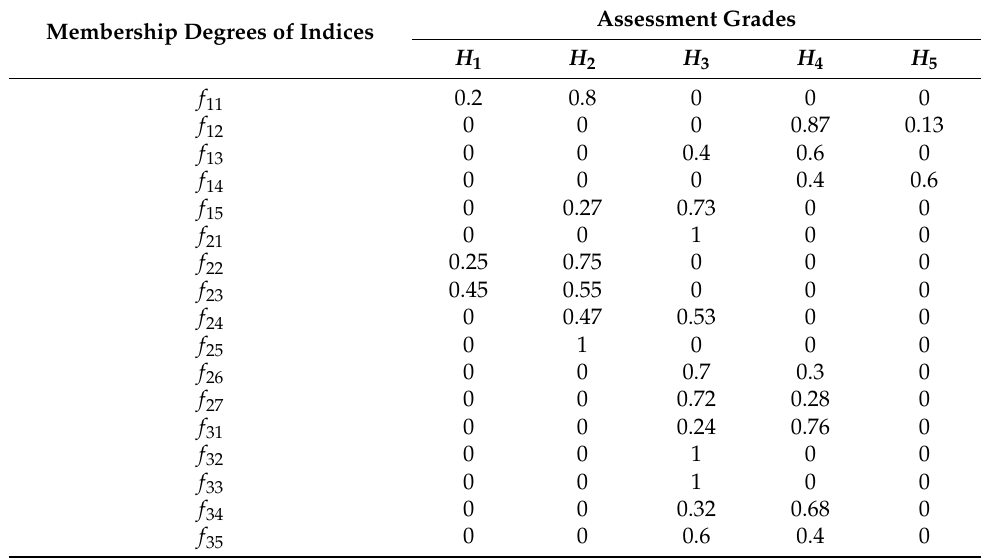
Table 4. Membership degrees to assess